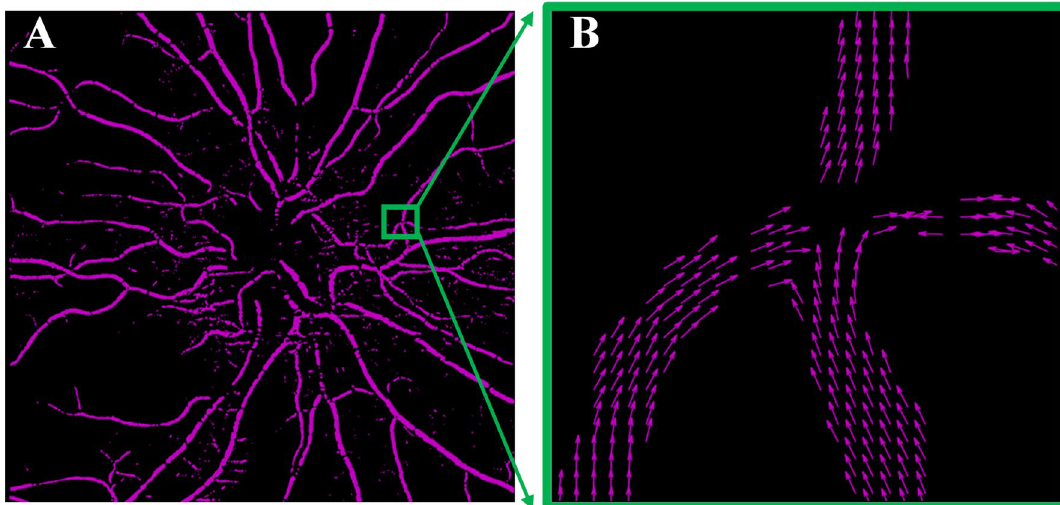
Figure 2. Illustration of vessel orientation extraction from OCTA image. (A) Vessel orientations were calculated by the Hessian matrix-based algorithm. (B) Enlargement of (A) : the arrows indicate the vessel directions/orientations. Note the algorithm is demonstrated on large vessels for illustration.